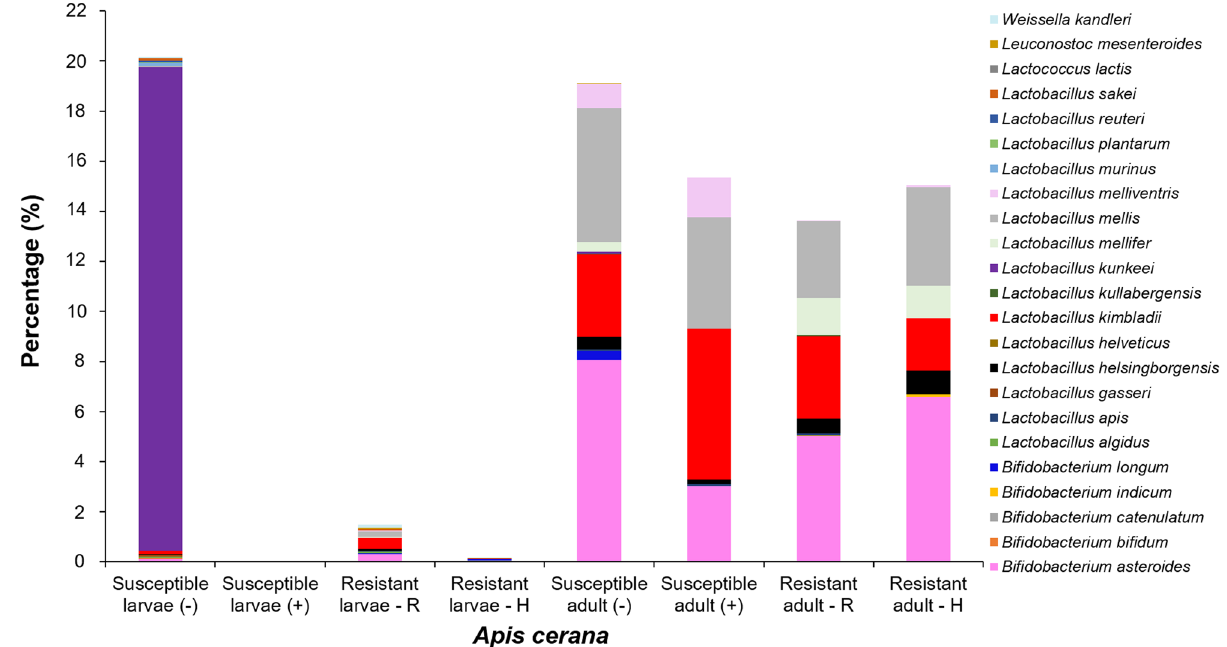
Figure 3. Lactic acid bacteria (LAB) in the gut of A. cerana . LAB were identified from the gut of adults and larvae of SBV-susceptible and -resistant strains (R and H) of A. cerana . The (−) and (+) symbols indicate healthy and SD-affected honey bees,